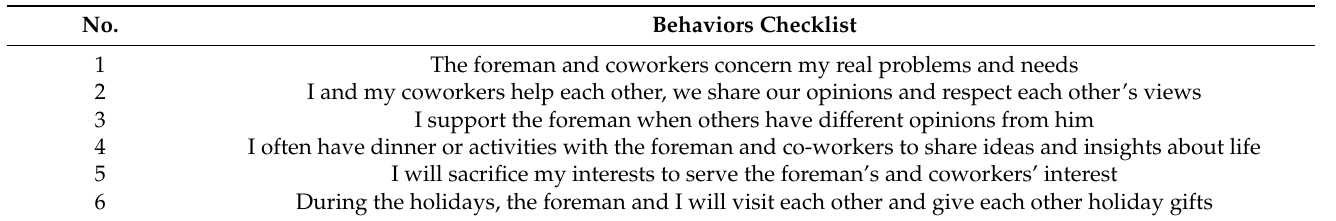
Table A1. Behaviors checklist for intra-group informal interaction.